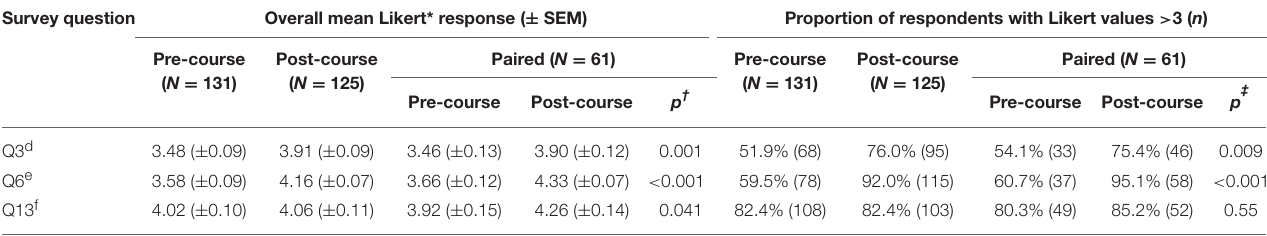
TABLE 3 | Total pre-course a , total post-course b , and paired c (by matched ID codes) survey responses to questions containing Likert Scale responses. Survey